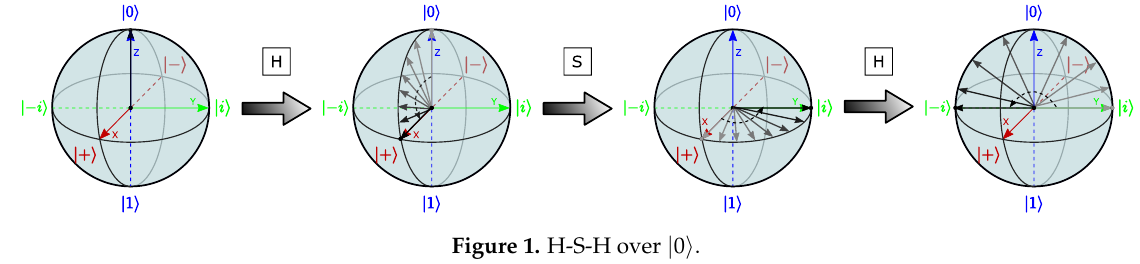
Figure 1. H-S-H over